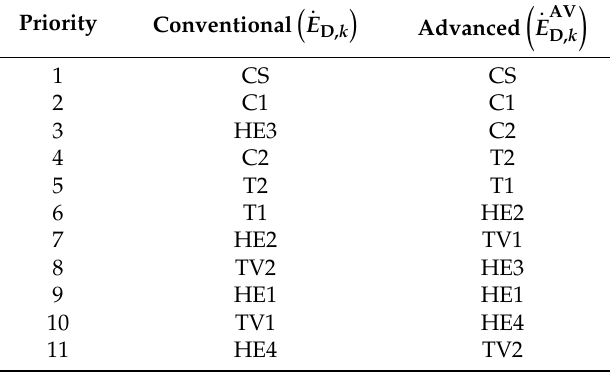
Table 6. Improvement priority of